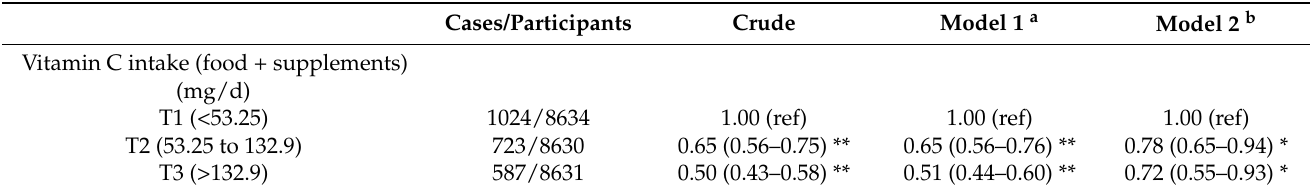
Table 7. Association between total vitamin C intake (food + supplements) and depressive